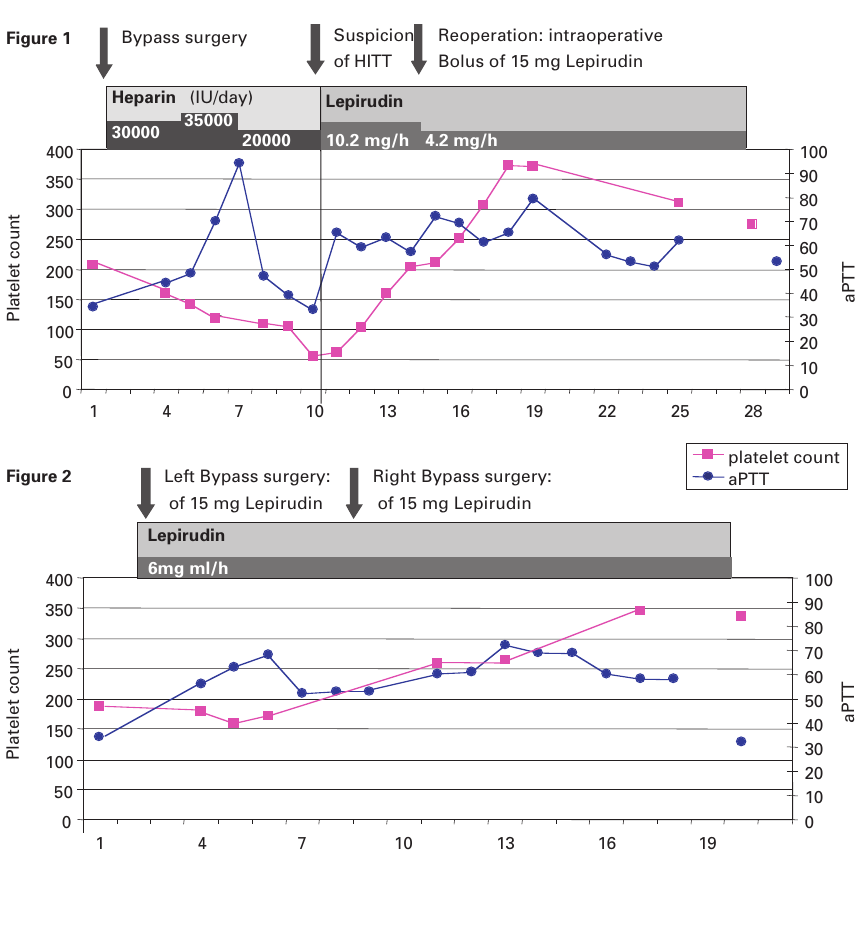
Changes in the platelet count during the initial heparin therapy are displayed: an immediate im- provement is seen after application of Lepirudin. Note the markedly reduced dose of Lepirudin needed to maintain the aPTT in the therapeutic range following removal of the thrombus (1). Note also the rapid and marked increase in the platelet count during administration of Lepirudin in the absence of active thromboembolism during the second hospitalisation